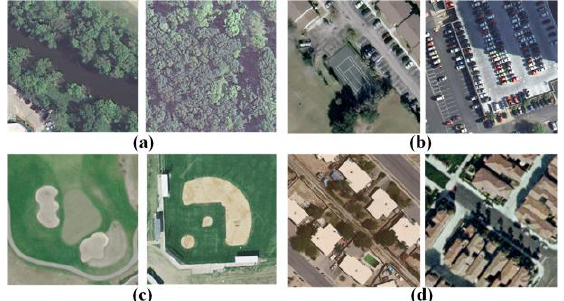
Figure 2. The high inter-class similarity in UC Merced dataset.